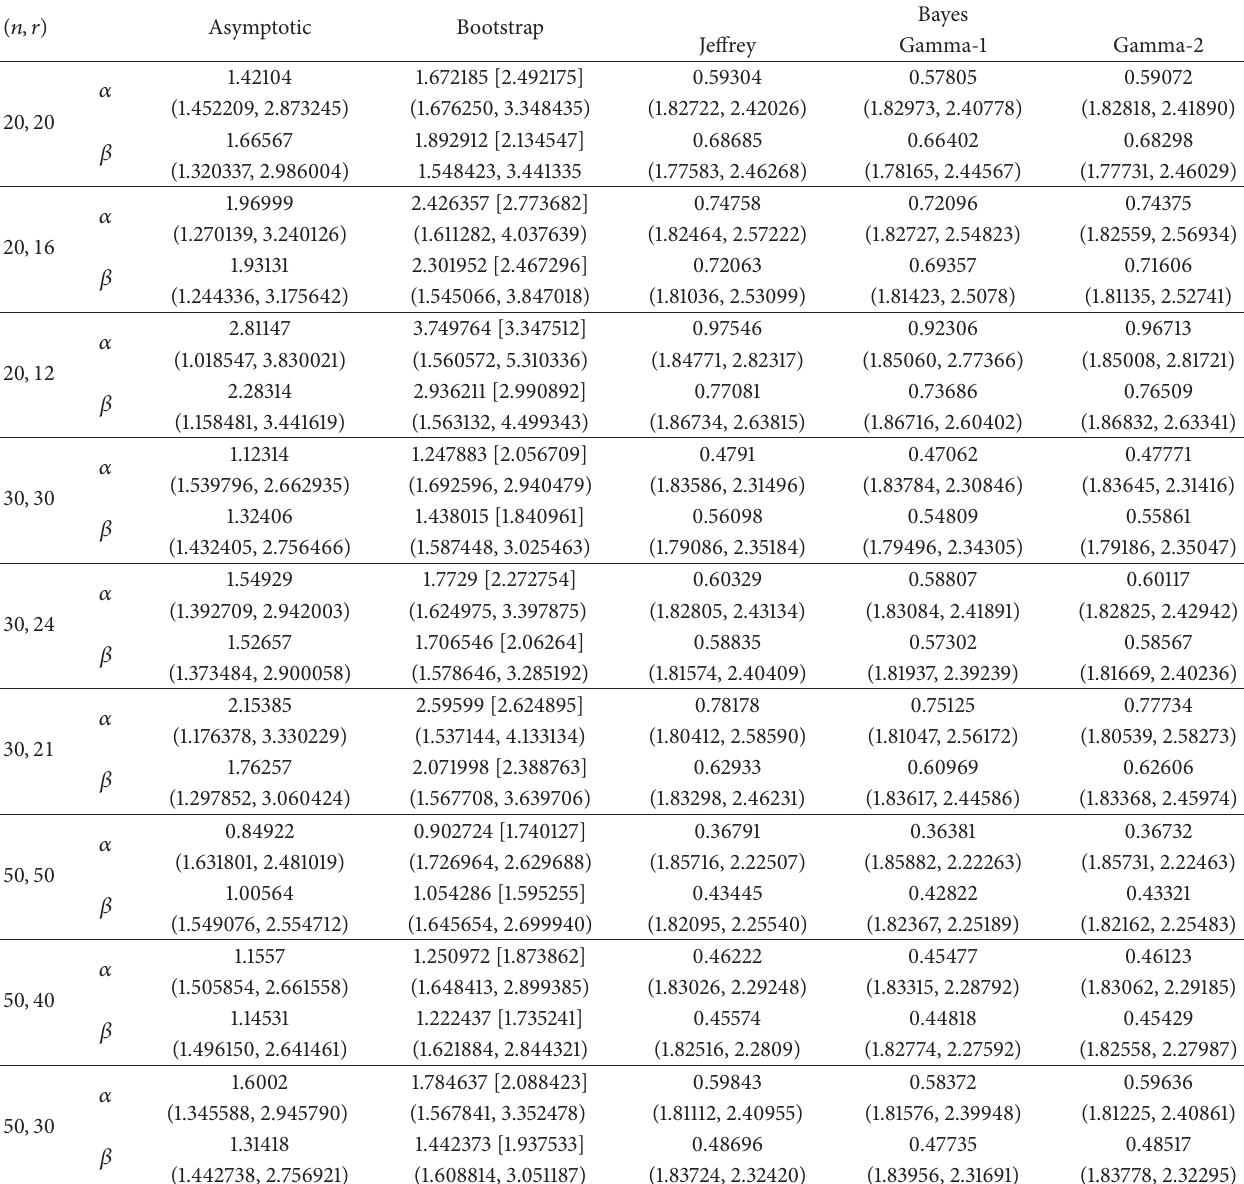
Table 5: Average 95% confidence/HPD/bootstrap intervals (in brackets) along with their width and shape (in square brackets) for bootstrap method under different Type-II censoring schemes for fixed 𝛼 = 2 and 𝛽 = 2